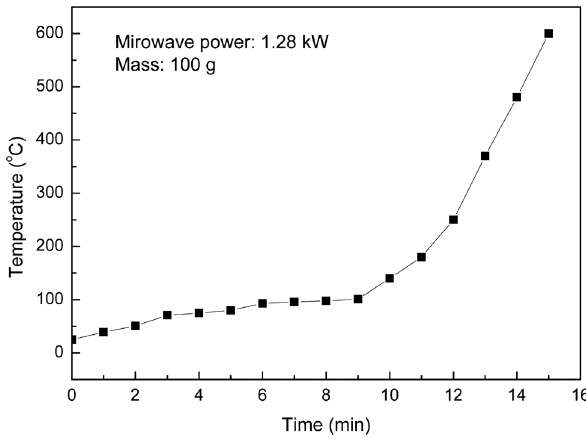
Fig. 1: The heating curve of CuCl residue under microwave irradiation (microwave power density: 1.28 kW/100 g)